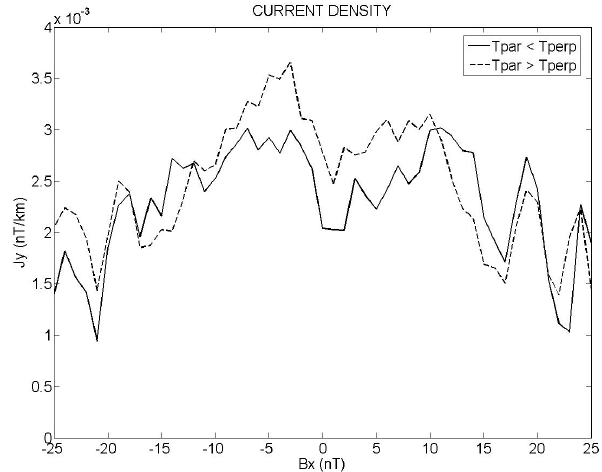
Fig. 6. The electric current density distributions j y (B x ) for differ- ent temperature anisotropy ratios R 1 .